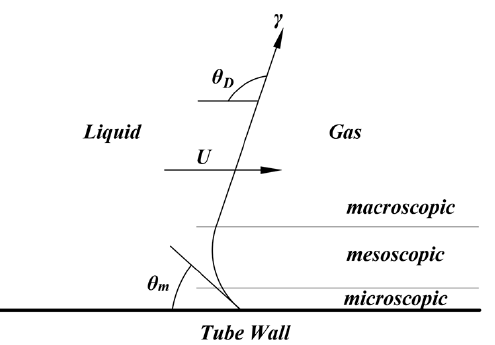
Figure 7. Schematic diagram of microscopic to the macroscopic scale of viscous liquid bending.